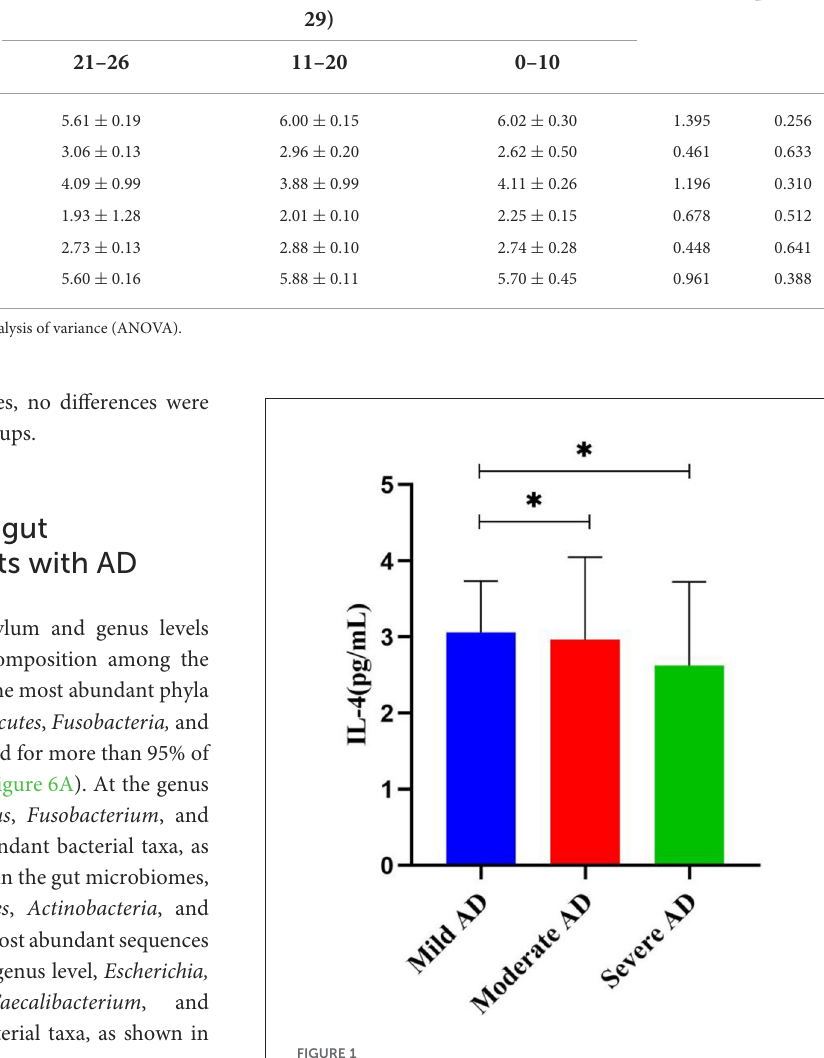
FIGURE1 Differences in serum IL-4 levels in different AD groups (mean ± SEM). * p <